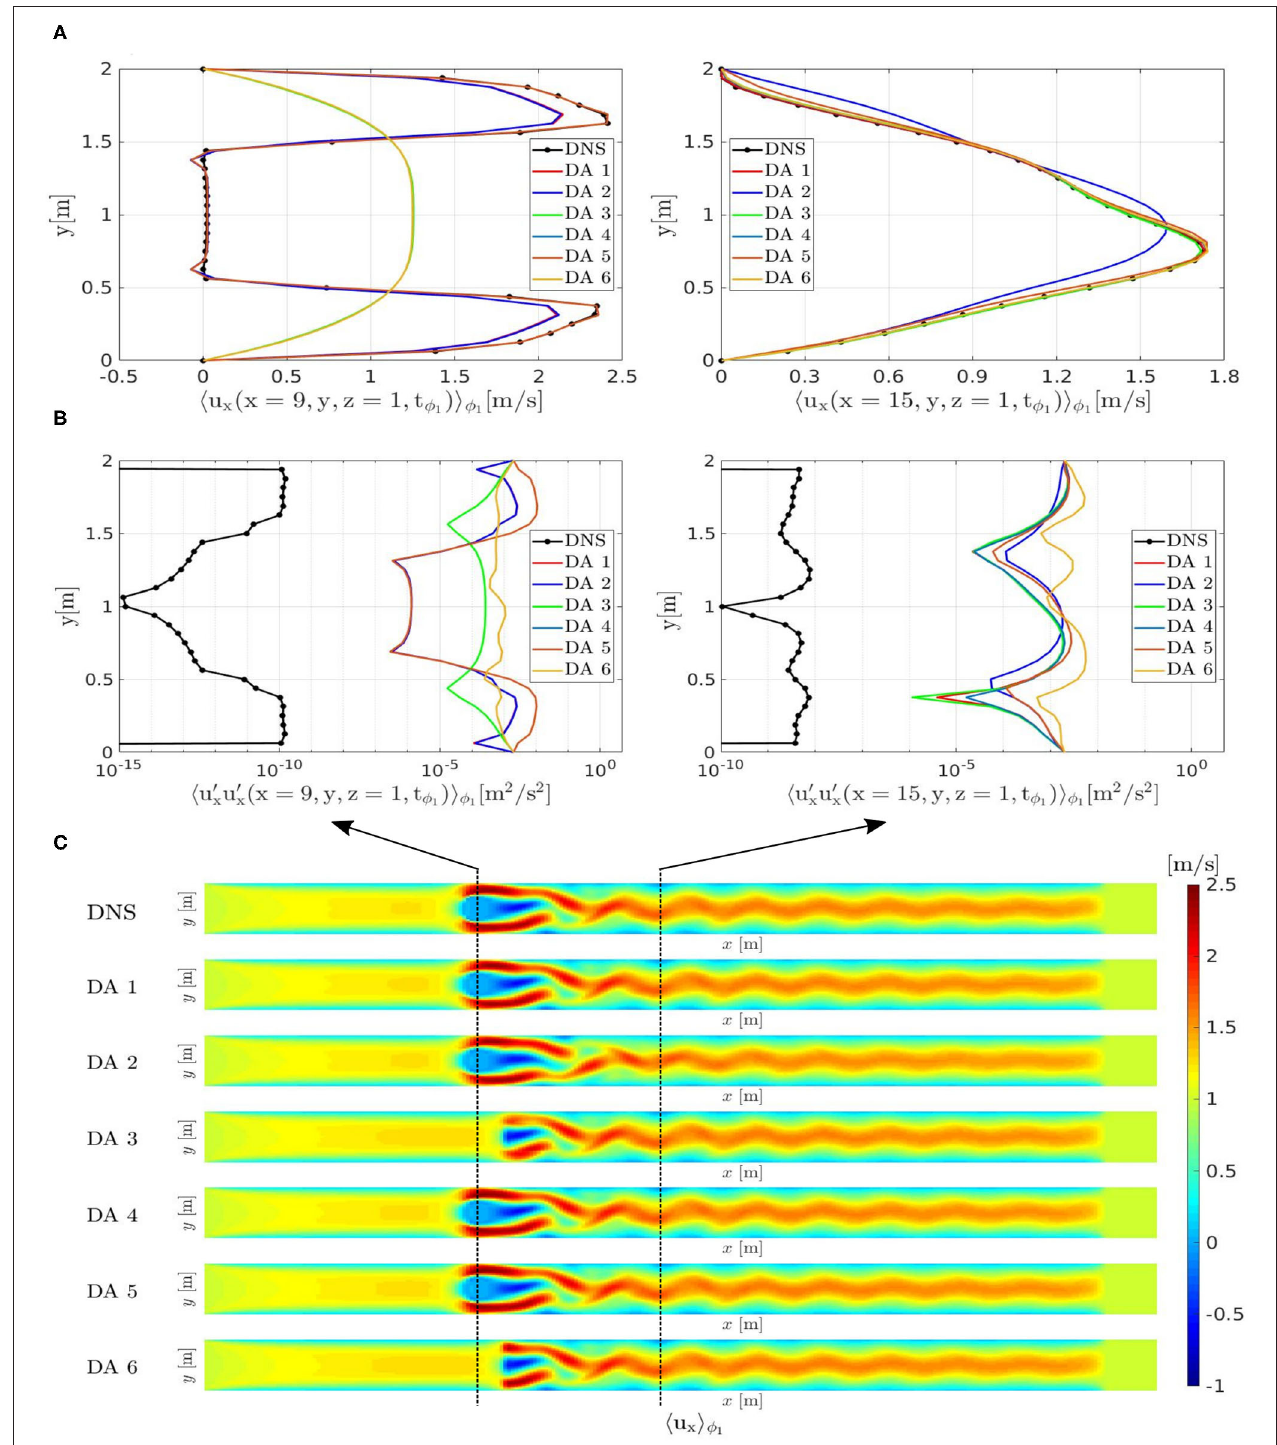
E x , t φ i φ (A) and xx -covariance component profiles h u ′ x 1 1 (cid:0) (cid:1)